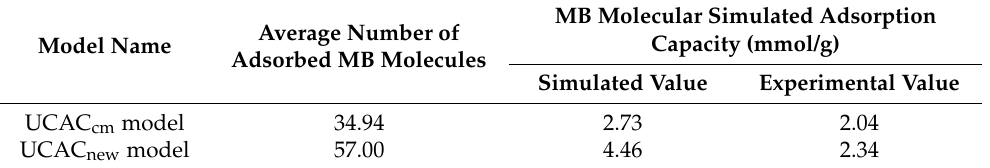
Table 4. Simulated adsorption amounts of UCAC new and UCAC cm models.